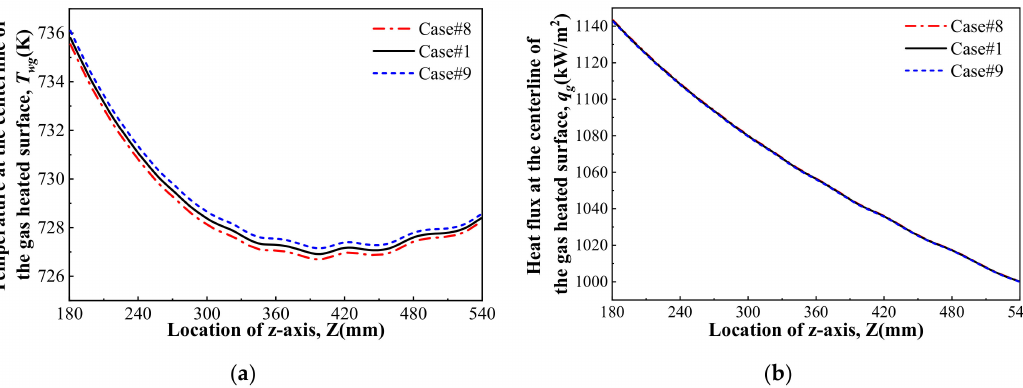
Figure 19. Variation of T wg and q g at the centerline of the gas heated surface with pressure of kerosene: ( a ) T wg ( b ) q g .